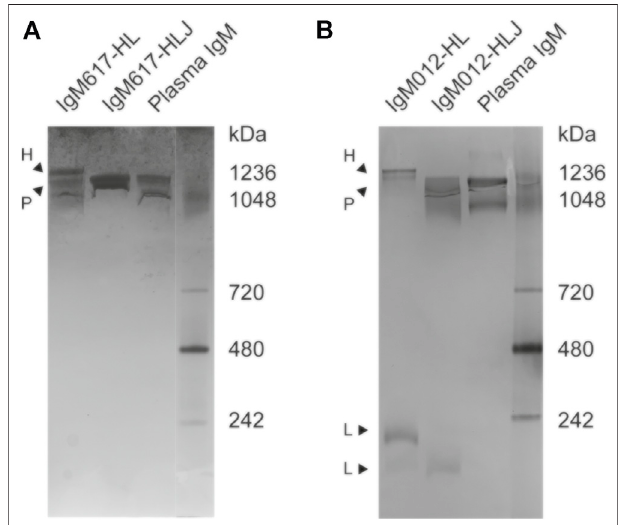
FIGURE 1 | Semi-native polyacrylamide gel electrophoresis (PAGE) analysisofpuri fi edIgMsamplesfromHEK293Fexpression. Native PAGEgels followed by Coomassie Blue stainingwere run to identify (A) IgM617-HLJ and IgM617-HL and (B) IgM012-HLJ and IgM012-HL polymer distributions after SEC puri fi cation. IgMs puri fi ed from plasma (antibodies-online GmbH) are taken as markers along with native markers (Novex NativeMark TM Unstained Protein Standard). Suspected hexamers (H), pentamers (P), and lower assemblies (L) are indicated with arrows.